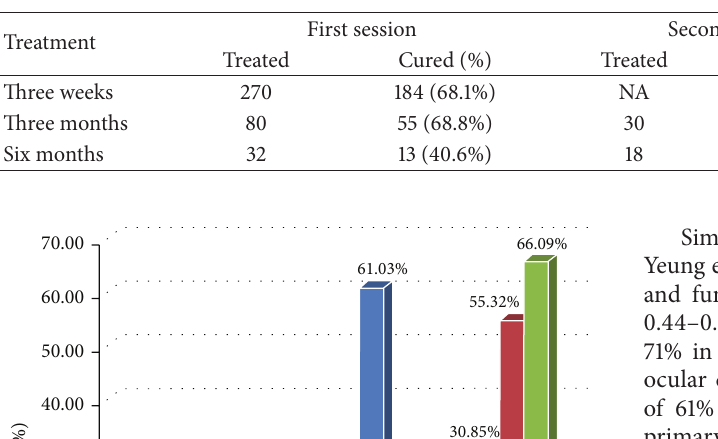
Table 1: Frequency and outcome of electrolysis per each follow-up.